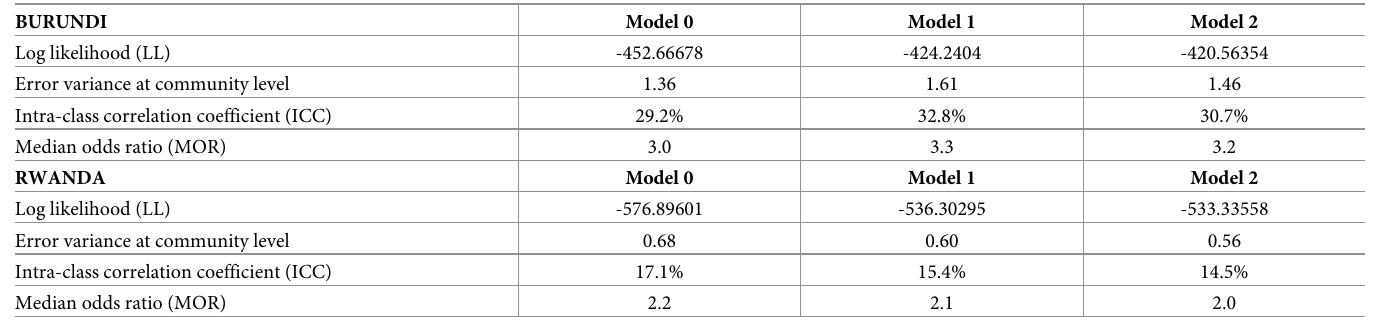
Table 2. Model estimates for factors associated with MDD-C in Burundi and Rwanda DHS2010.